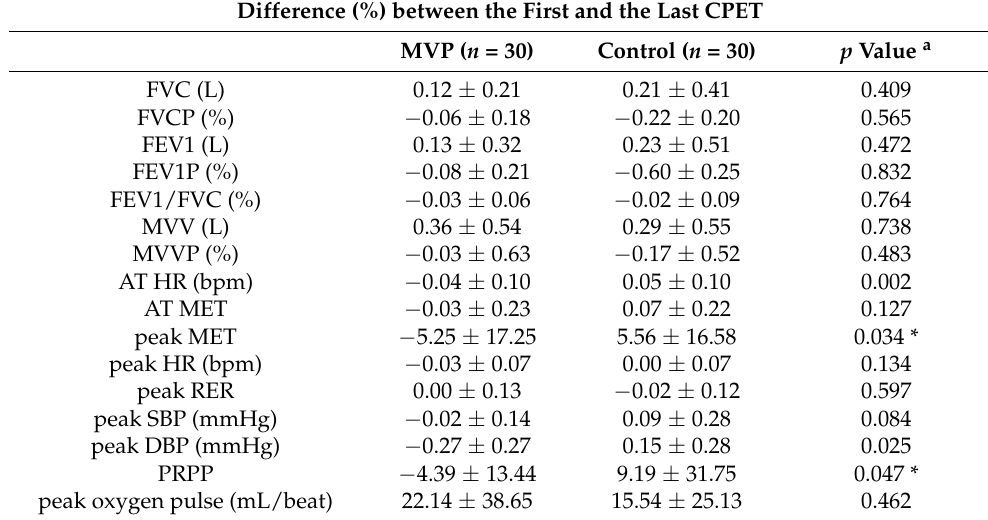
Table 3. Comparison of the change of variables of the last from the first cardiopulmonary exercise testing between the mitral valve prolapse group and the control group. Difference (%) between the First and the Last CPET MVP ( n = 30) Control ( n = 30) p Value